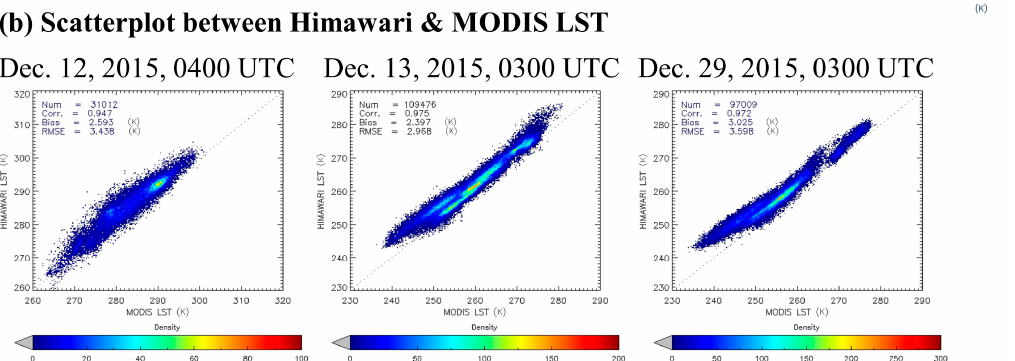
Figure 14. Same as Figure 13 except for the selected days.